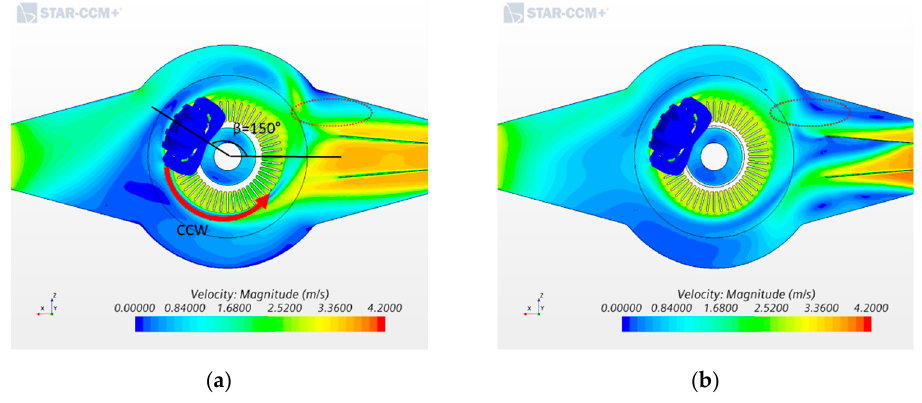
Figure 13. Flow velocity magnitude for the inlet duct: ( a ) two splitters; ( b ) four